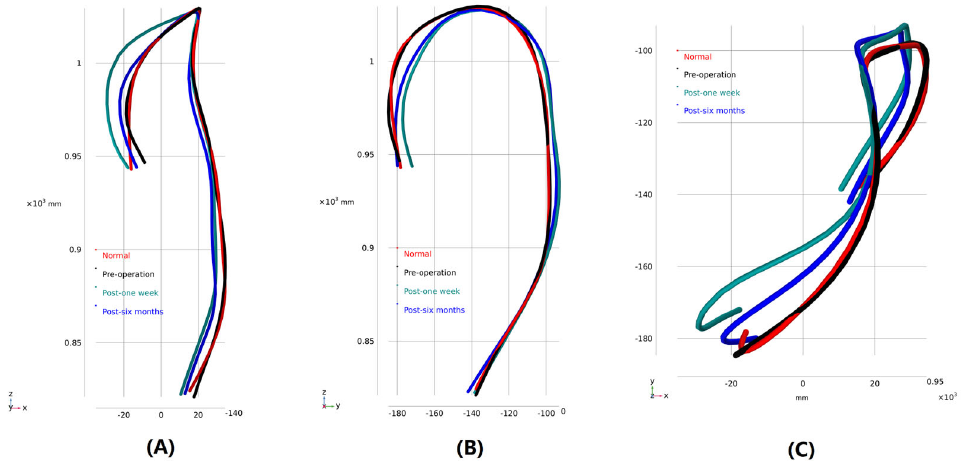
Figure 4. Vessel centerline (contains no branches). ( A ) Coronal plane view; ( B ) 90° anti-clockwise rotation of coronal plane view; ( C ) Horizontal plane view.